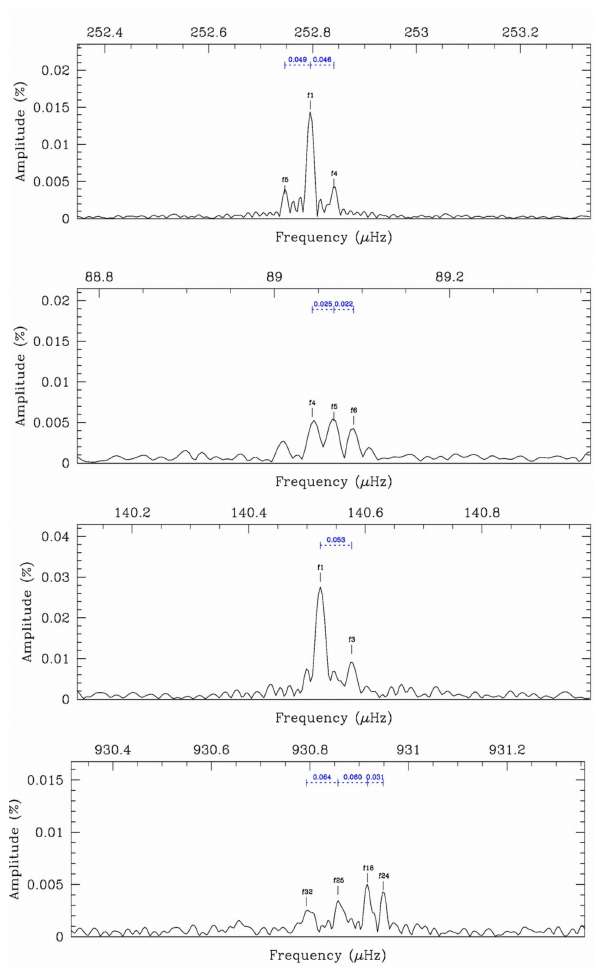
Figure 2. Hints of multiplet structures, possibly due to rotation, resolved just above the frequency resolution limit for several modes observed in the star KIC 10001893 monitored during 1111 days by the Kepler spacecraft (see